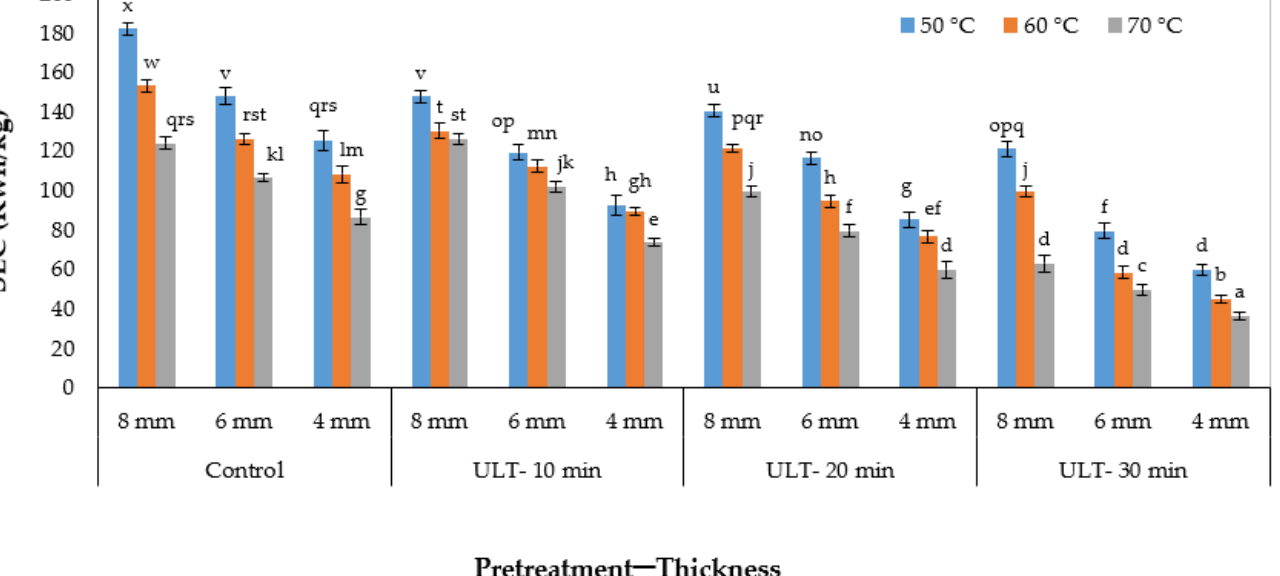
Figure 3. Amounts of SEC under different conditions for kiwifruit slices.